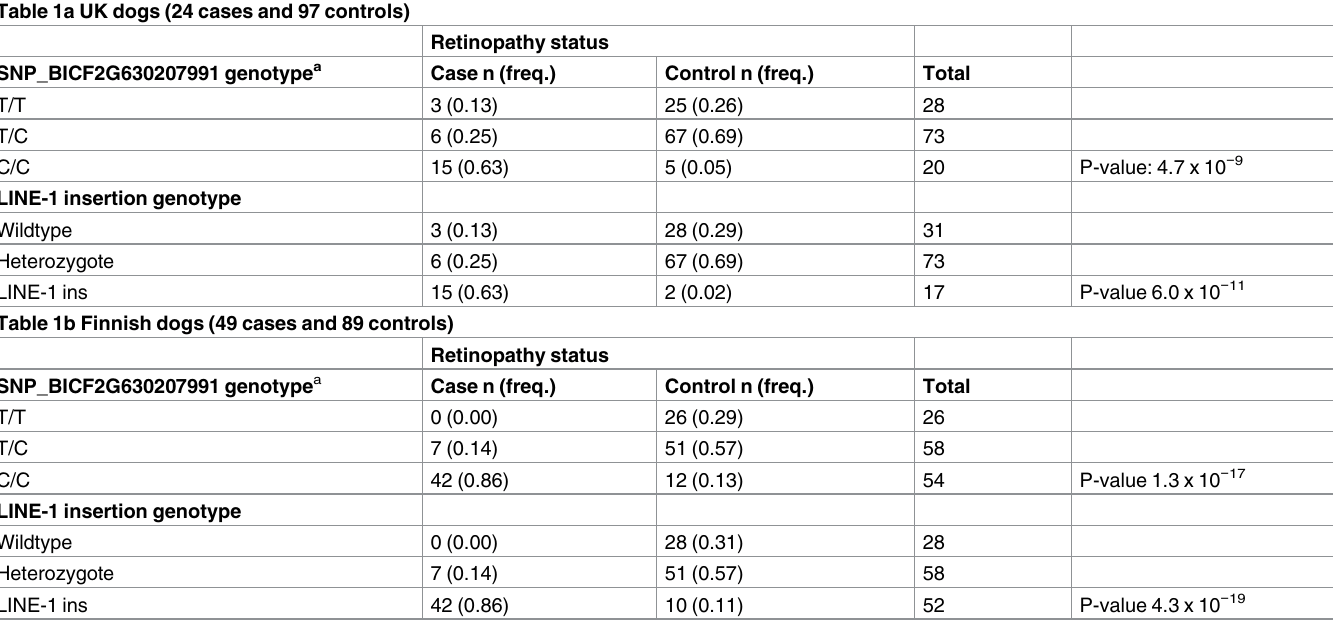
Table 1. Genotypes for top GWAS SNP and LINE-1 insertion in Swedish Vallhunds from the UK and Finland. Table 1a UK dogs (24 cases and 97 controls)